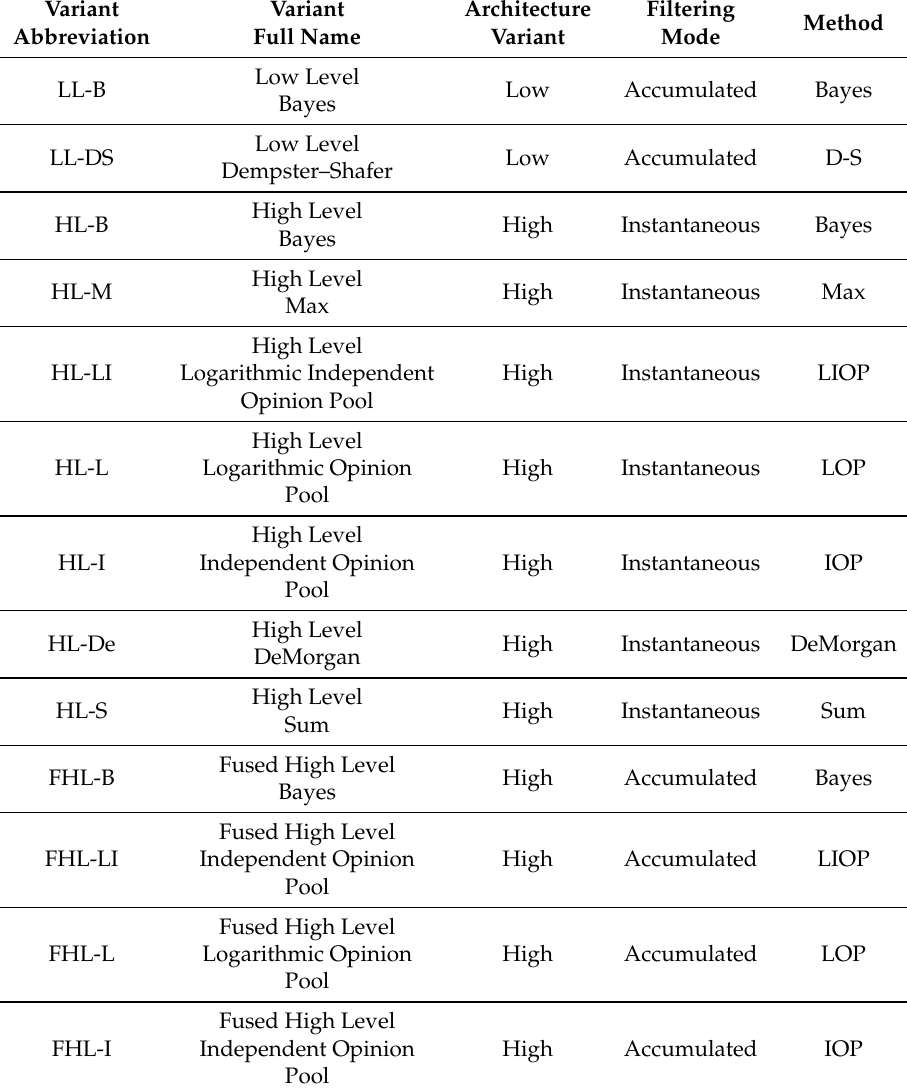
Table 1. Tested configurations and their